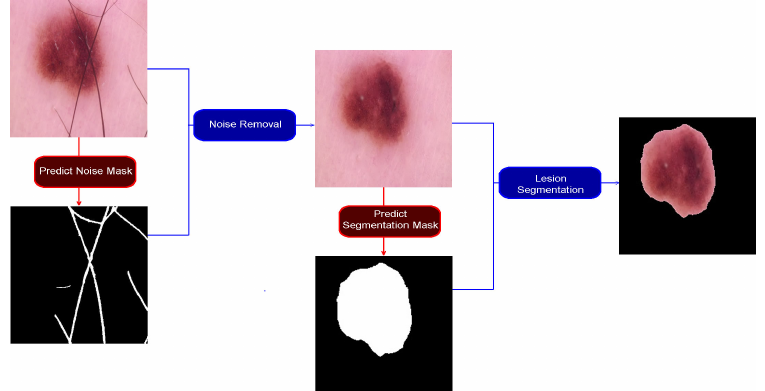
Figure 1. The overall representative structure of the